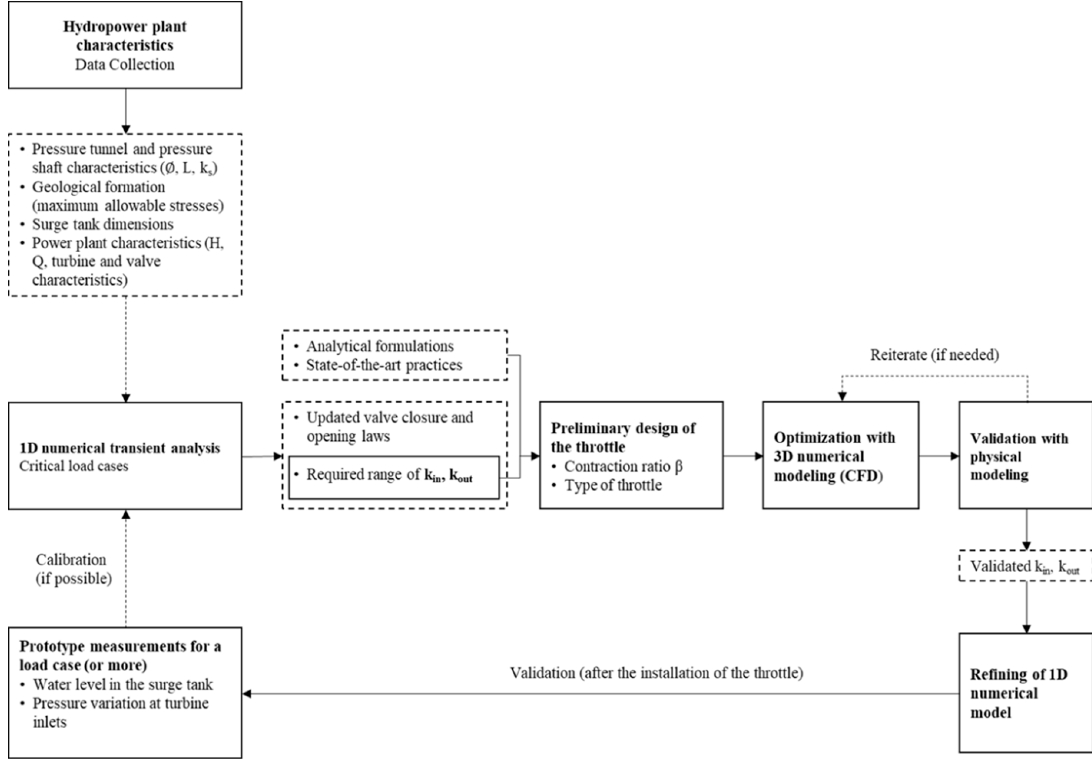
Figure 13. Holistic approach to design throttled surge tanks (during a refurbishment of a high-head power plant).